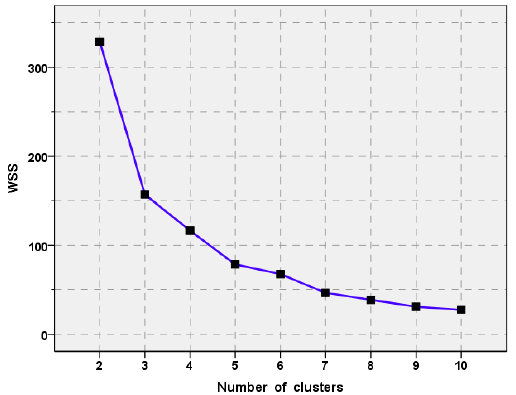
Figure 8. Elbow method to determine the number of clusters.